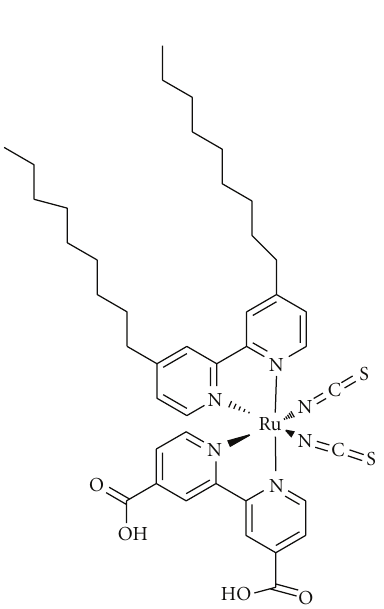
Figure 3: Molecular structure of Z907 (taken from [16, 17]).